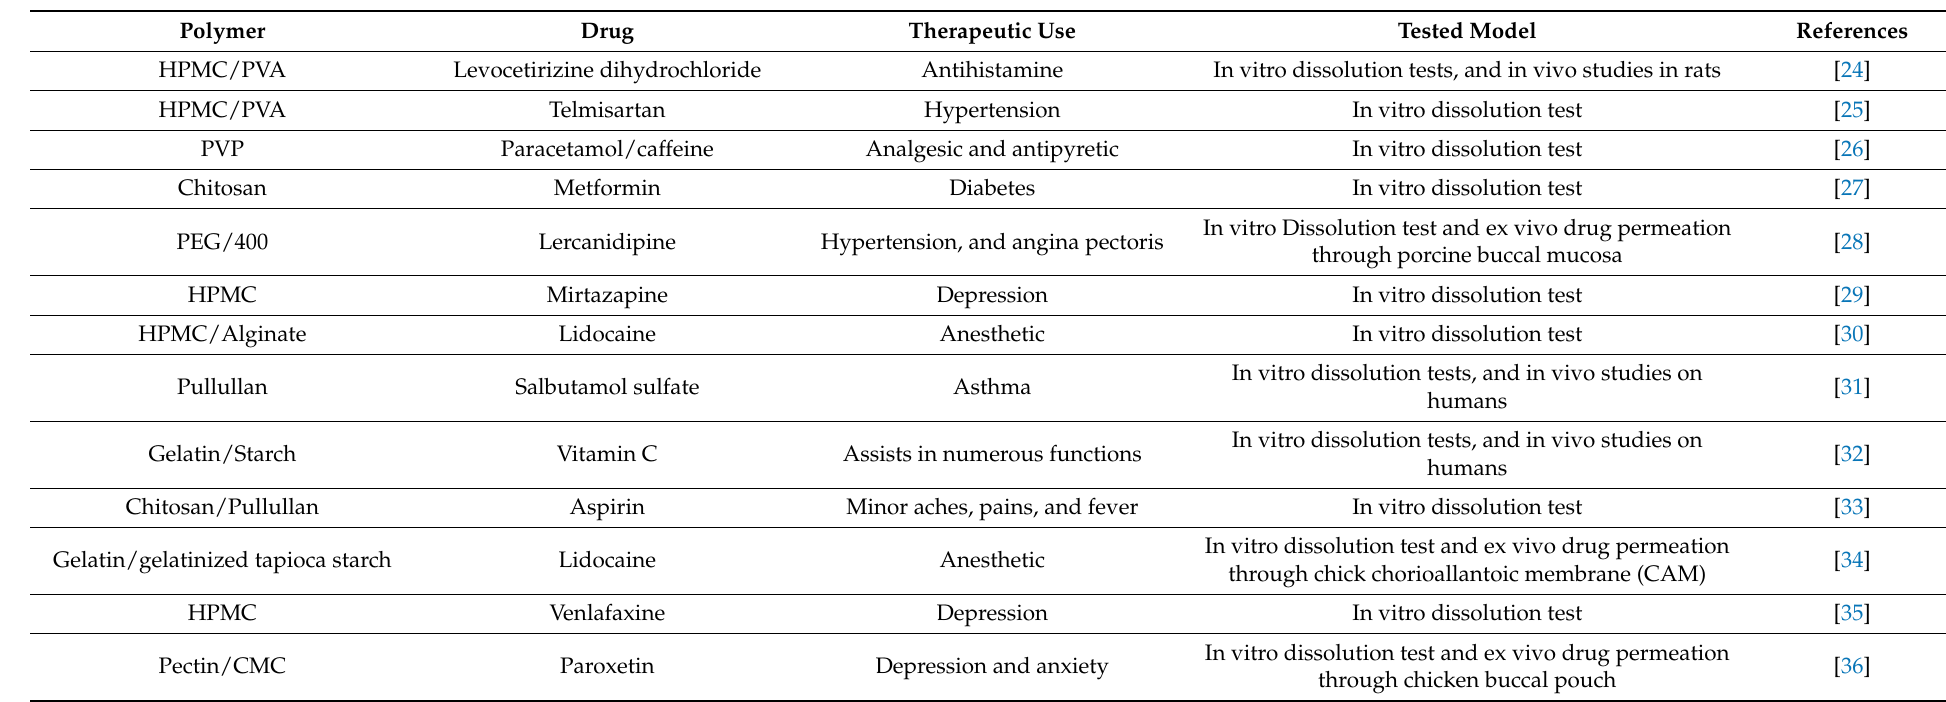
Table 1. Examples of drugs and polymers used in the formulation of oral fast-dissolving films